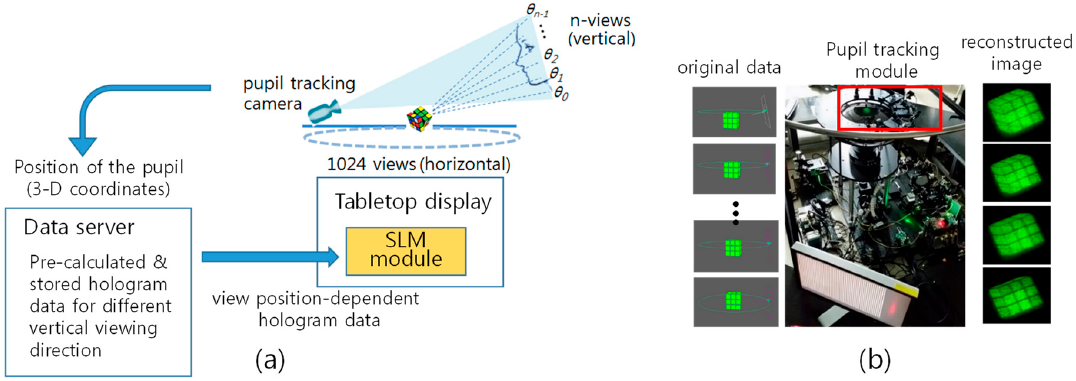
Figure 6. Vertical parallax support by using pupil tracking and dynamic hologram update. ( a ) Conceptual model and ( b ) 180° pupil tracking module and hologram images seen at four different vertical viewing position.